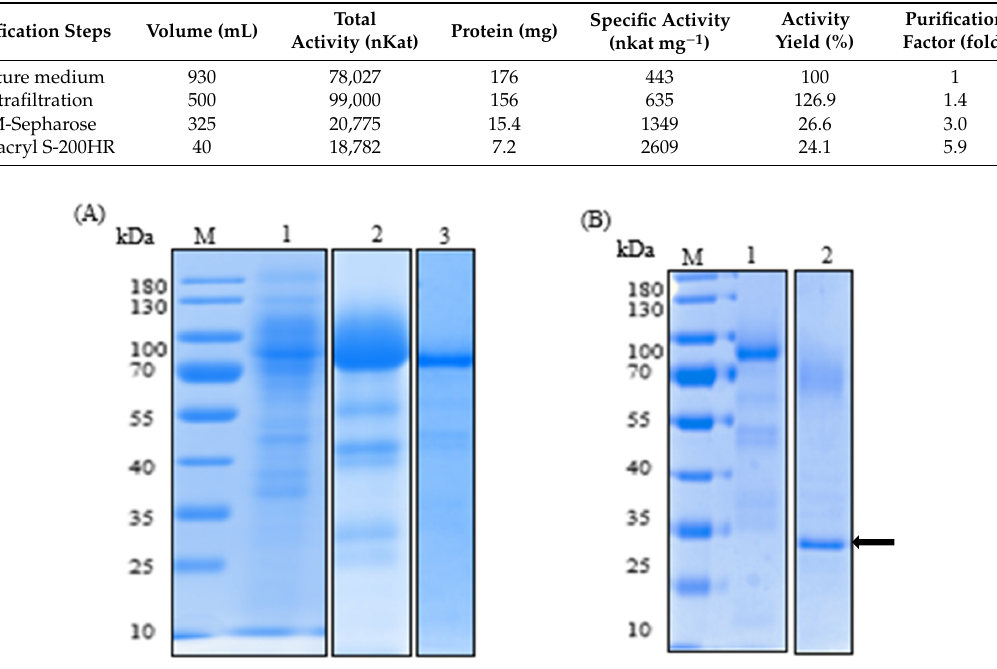
Figure 1. Sodium dodecyl sulfate-polyacrylamide gel electrophoresis (SDS-PAGE) (12% polyacrylamide gels) and N-glycosylation analysis of the purified Sl Lac2. Three-step purification procedure of Sl